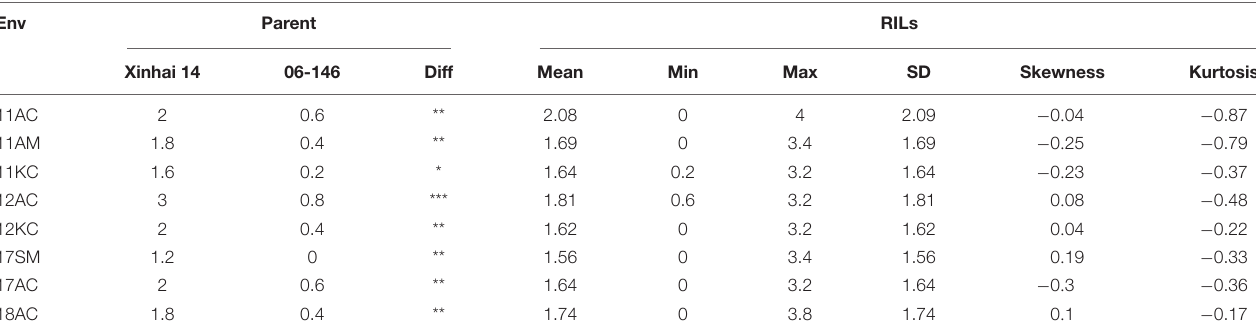
TABLE 1 | Disease severity rating in Xinhai 14, 06-146 and their RIL population of 110 lines.